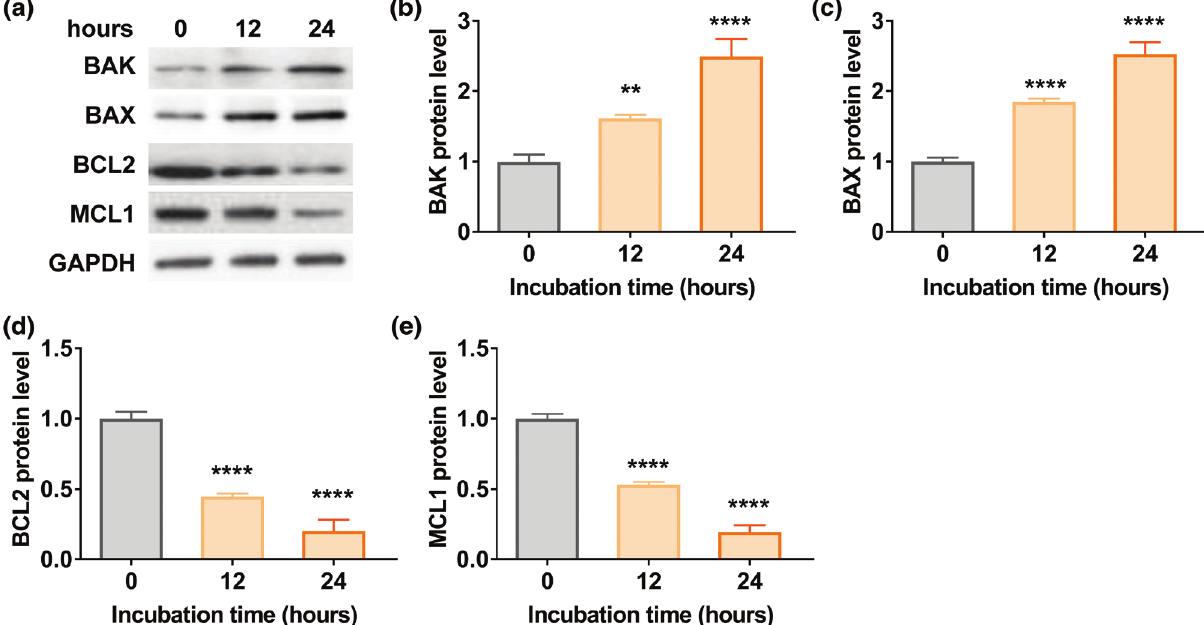
Fig. 3. Anethole regulated the expression of apoptosis-related proteins in A549 cells. A549 cells were treated with 50 μM aneth- ole for indicated times, and then cells were harvested to determine the protein levels of BAK (a and b), BAX (a and c), BCL2 (a and d), and MCL1 (a and e) by Western blot. Four replicated wells for each condition were performed. Error bar represents SEM. ** P < 0.01 and **** P < 0.0001.